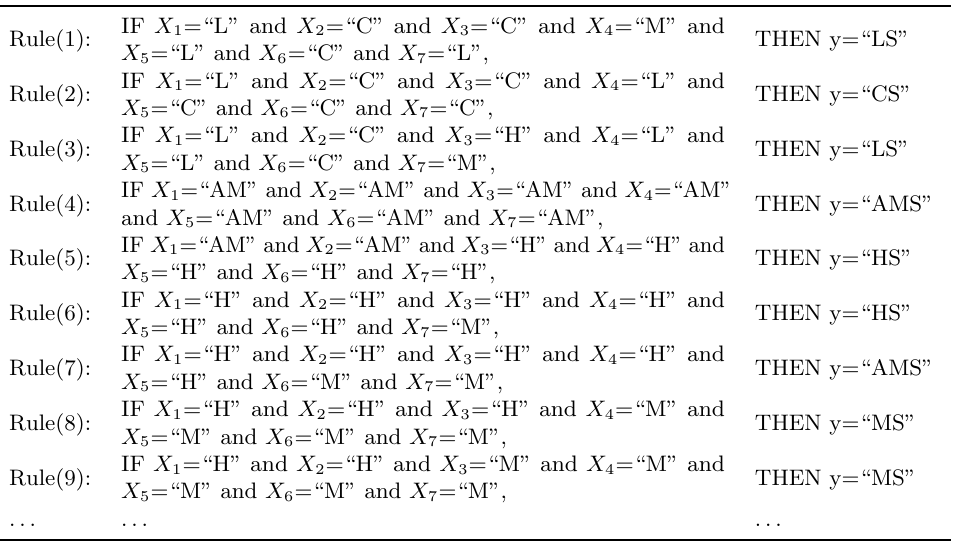
Table 7: Fragment of a fuzzy knowledge base for aggregated